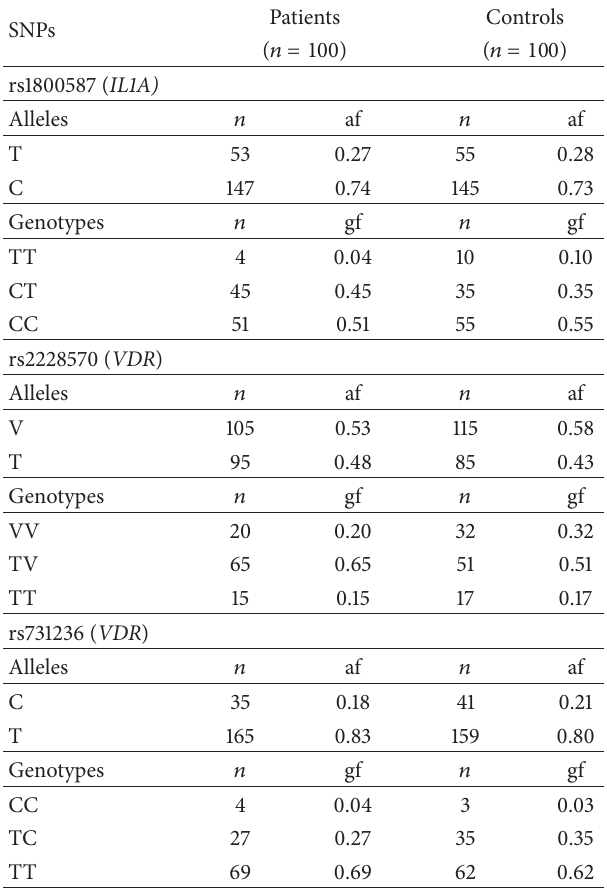
Table 2: Allelic ( af ) and genotype ( gf ) frequencies of IL1A and VDR polymorphisms in controls subjects and patients with